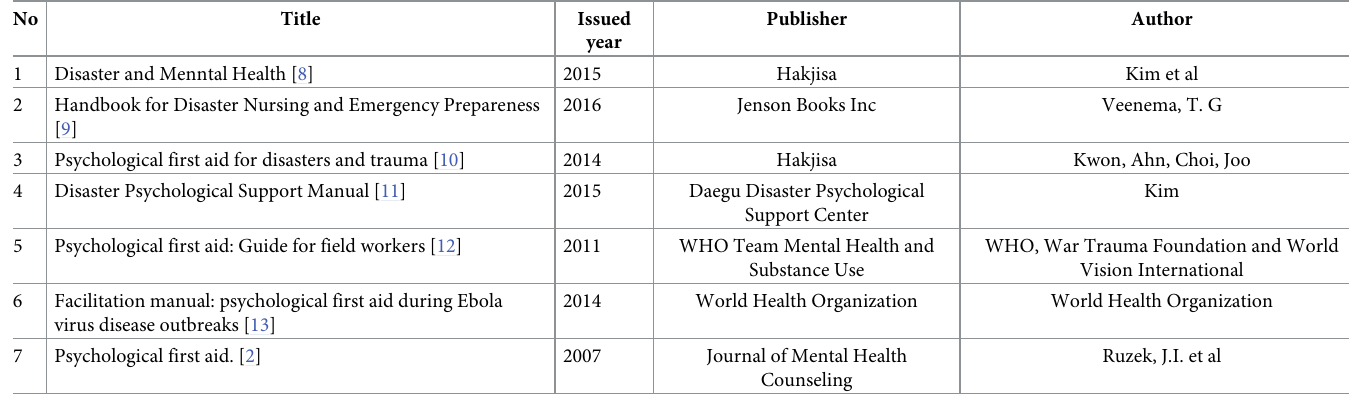
Table 1. Ontology